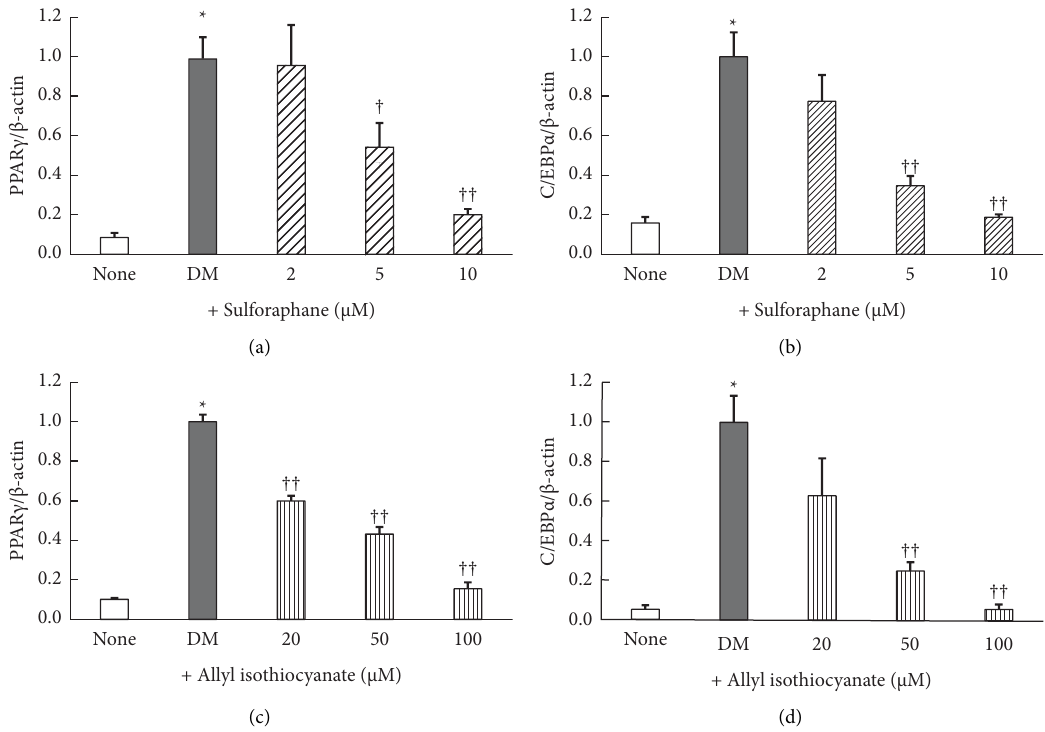
Figure 5: Peroxisome proliferator-activated receptor c (PPAR c ) and CCAAT-enhancer binding protein α (C/EBP α ) mRNA expression levels in 3T3-L1 adipocytes treated with (a, b) sulforaphane or (c, d) allyl isothiocyanate. Data are presented as the mean ± standard error ( n � 3-4). ∗ denotes P < 0 . 01, versus untreated cells (none); † denotes P < 0 . 05; †† denotes P < 0 . 01, versus cells cultured in differentiation medium